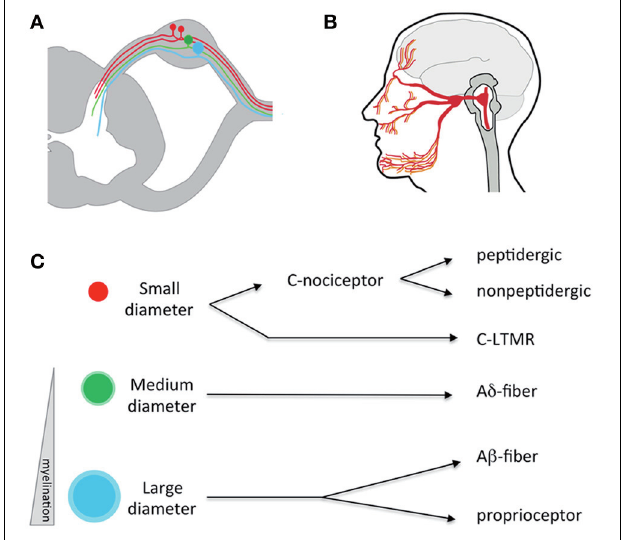
FIGURE 1 | Anatomy of the somatosensory system. (A) Somatosensory neuron cell bodies reside outside the spinal cord in the dorsal root ganglia (DRG). They have a single process that splits, sending an afferent projection to the periphery and an efferent projection to the spinal cord. (B)